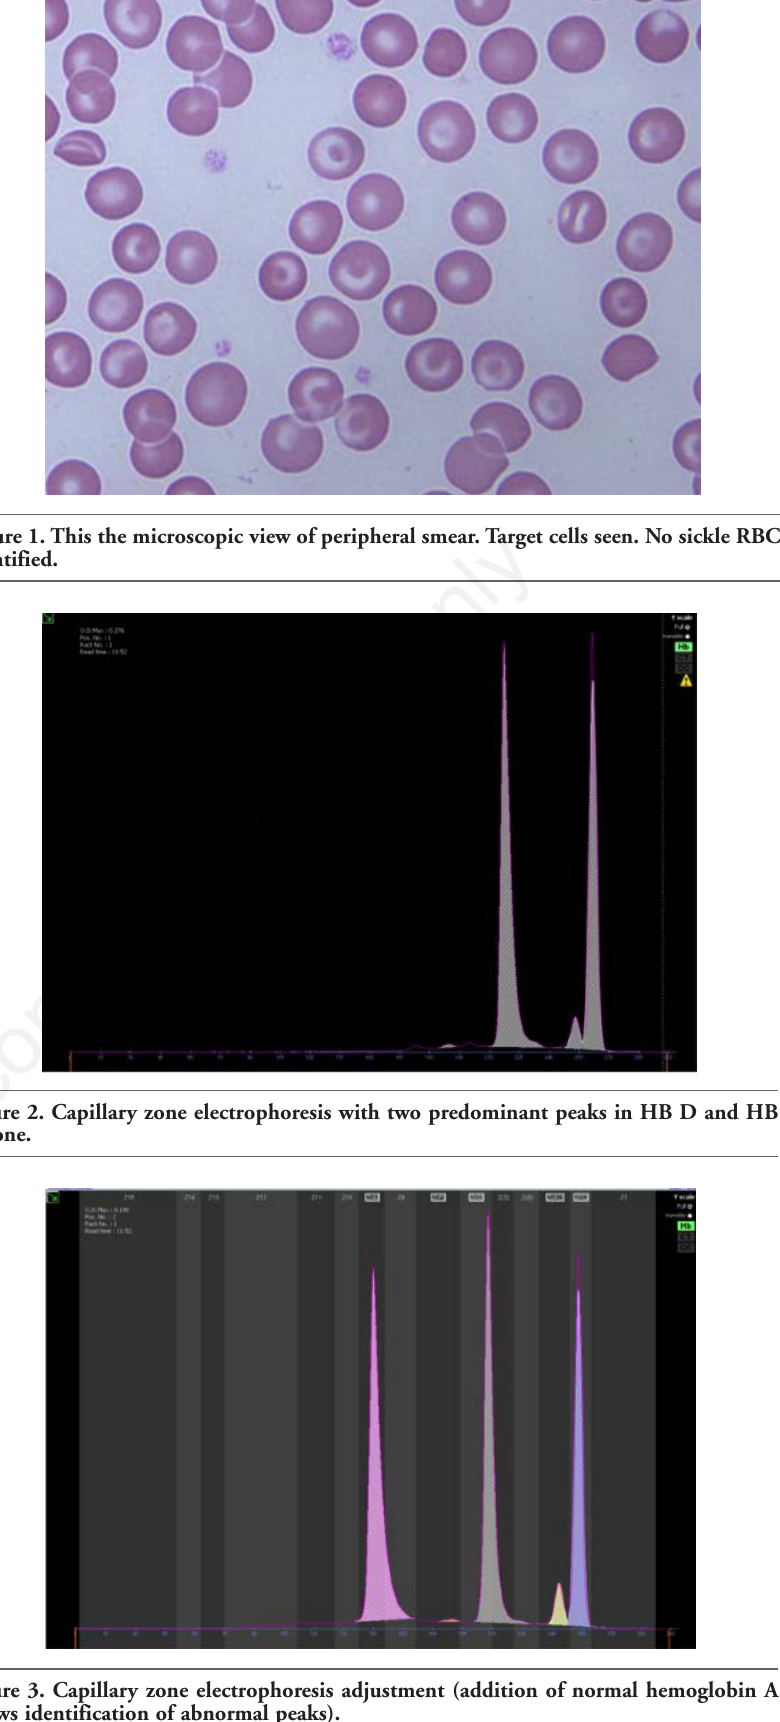
Figure 3. Capillary zone electrophoresis adjustment (addition of normal hemoglobin A allows identification of abnormal